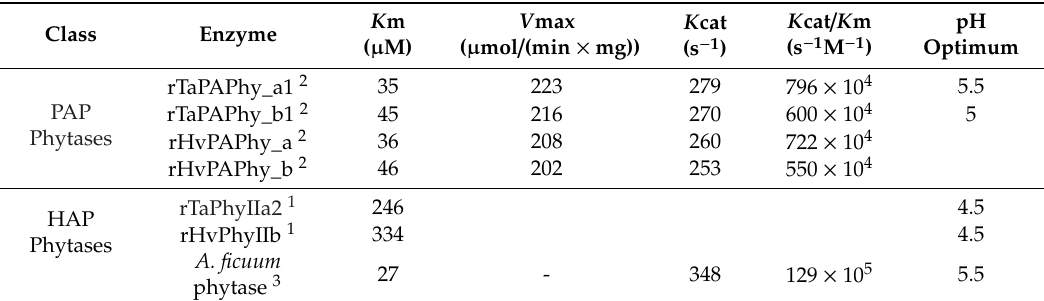
Table 2. Kinetic parameters from HAP and PAPhy phytases from wheat, barley, and Aspergillus ficuum . Data from 1 [15], 2 [16], 3